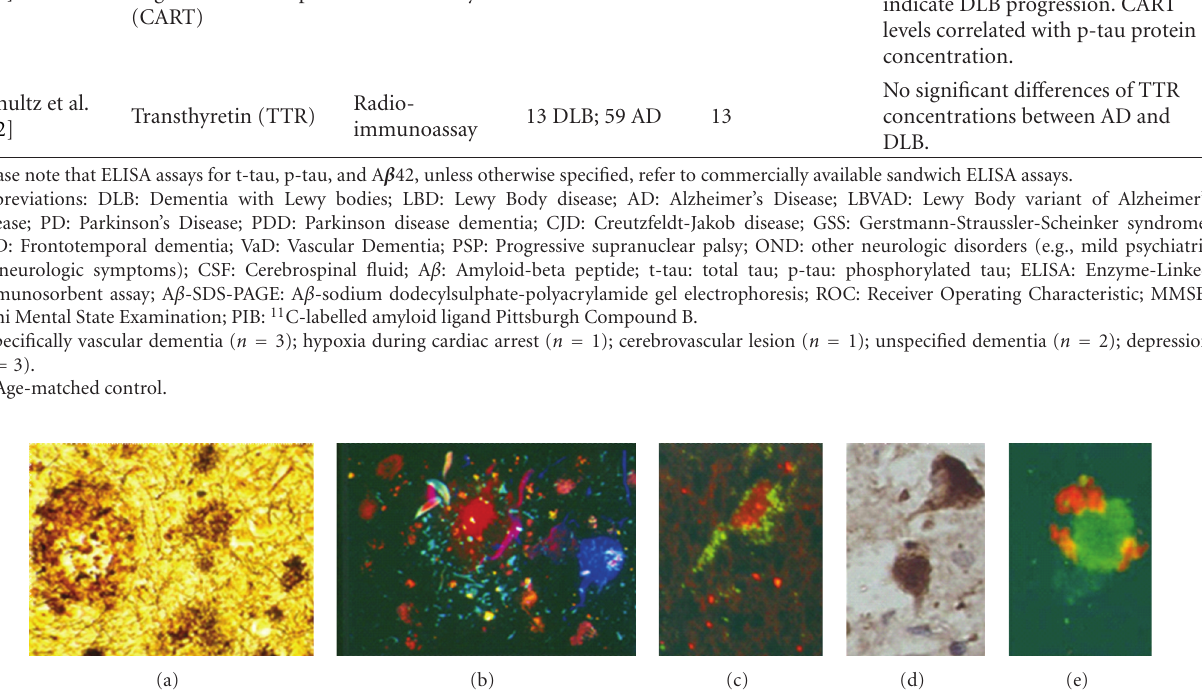
Figure 1: Neuropathological hallmarks of dementia. Senile plaques (a) containing amyloid protein and neurofibrillary pathology (b) consisting of altered tau protein are the hallmarks of Alzheimer’s disease and ageing. In dementia, loss of synaptic proteins a ff ects both allo- and neocortical areas. In Dementia with Lewy body, intraneuronal aggregates of α -synuclein give rise to Lewy bodies ((d),(e)) that are also found in normal ageing and in other neurodegenerative diseases, including AD and PDD. Light microscopy ((a), (d)); confocal microscopy ((b), (c), (e)). Labelling: Bielschowsky silver (a), tau immunohistochemistry (b), synaptophysin labelling (c), and alpha- synuclein immunohistochemistry ((d), (e)). Magnification: x100 (a) and x400